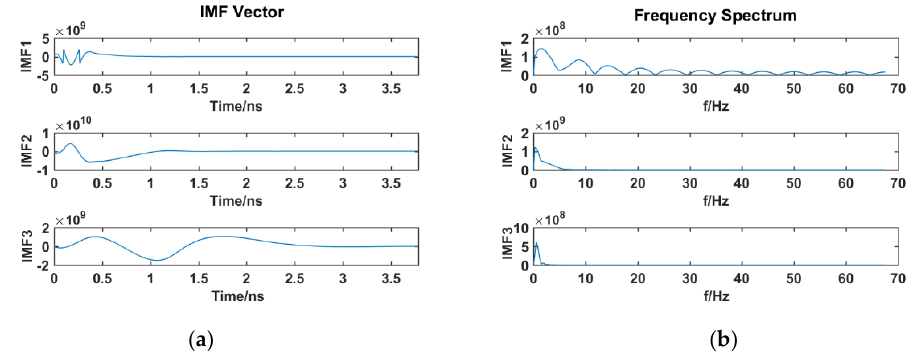
Figure 6. The results of one signal after empirical mode decomposition (EMD) analysis. ( a ) The Intrinsic Mode Function (IMF) components; ( b ) The frequency spectrum.